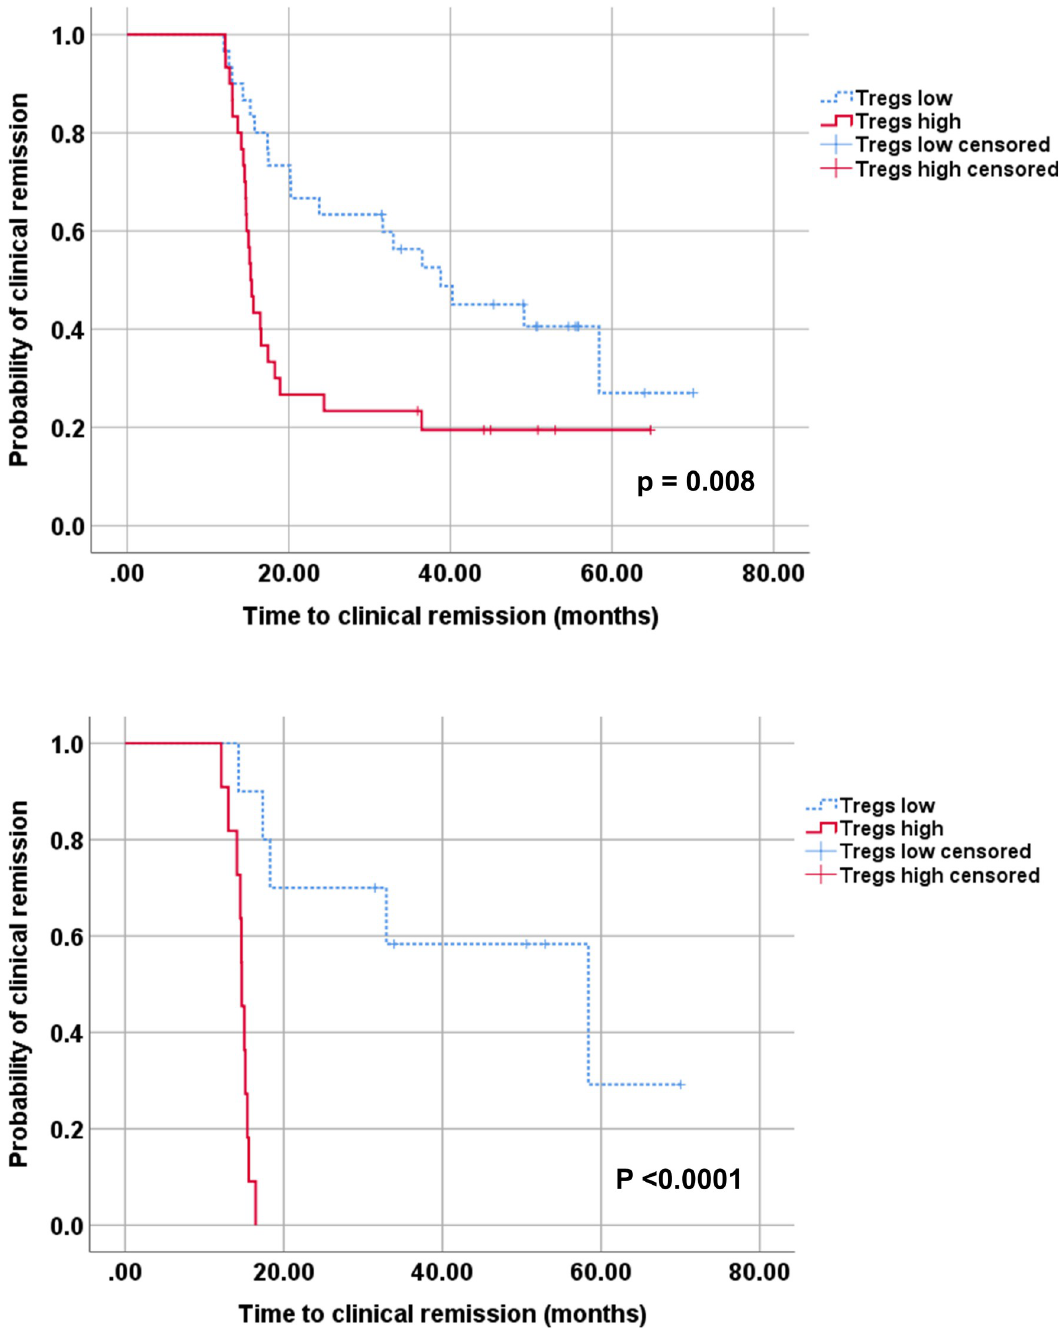
Fig 6. Kaplan–Meier analysis of clinical remission in juvenile-onset systemic lupus erythematosus patients. All JSLE patients (A), the Tregs high group (%Tregs � 0.9, n = 30) and Tregs low group (%Tregs < 0.9, n = 30) were stratified by the median percentage of Tregs in all JSLE patients at enrollment. Treatment-na ï ve JSLE patients (B), the Tregs high group (%Tregs � 1.7, n = 11) and Tregs low group (%Tregs < 1.7, n = 10) were stratified by the median percentage of Tregs in treatment-naive JSLE patients at enrollment. Clinical remission means remission on therapy (physician global assessment of disease activity < 0.5 on a 0–3 scale, daily prednisolone dose � 5 mg/day or � 0.2 mg/kg/day for body weight < 25 kg, with or without antimalarials and